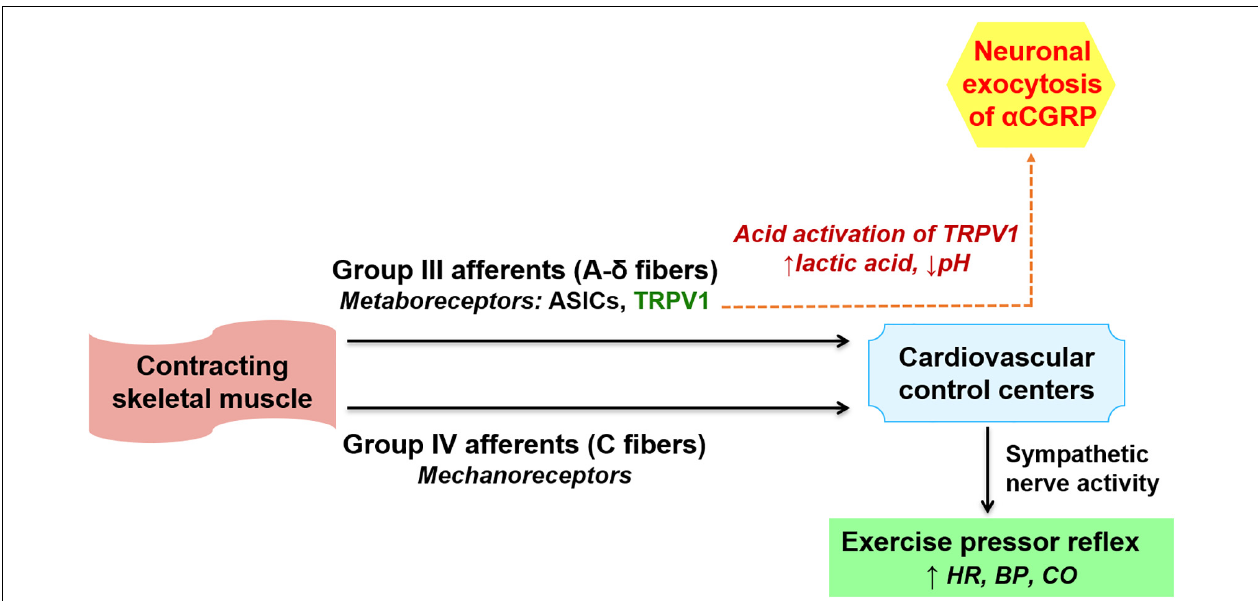
FIGURE 1 | Mechanism of α CGRP release associated with exercise pressor reflex. During exercise, group III and IV afferent neurons within skeletal muscles are activated. This activates the sympathetic nervous system resulting in exercise pressor reflex (lower part of the figure). During exercise, tissue acidification (lactate production and drop in pH) induces α CGRP release from group III afferents through activation of transient receptor potential vanilloid subtype 1 (TRPV1) channels (dashed arrow, upper part of the figure). Post release, α CGRP entering the circulation may trigger physiological cardiac hypertrophy in normotension and mediate cardio-protection during pressure overload. ASICs, acid sensing ion channels, HR, heart rate, BP, blood pressure, CO, cardiac